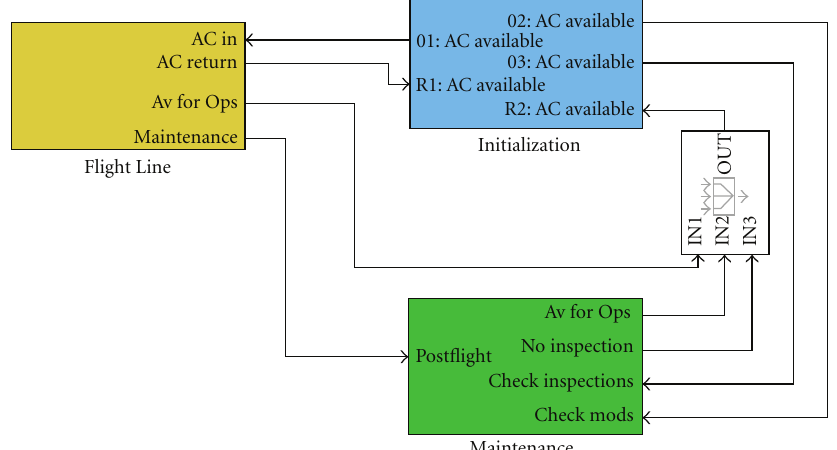
Figure 2: OR-SIM SimEvents